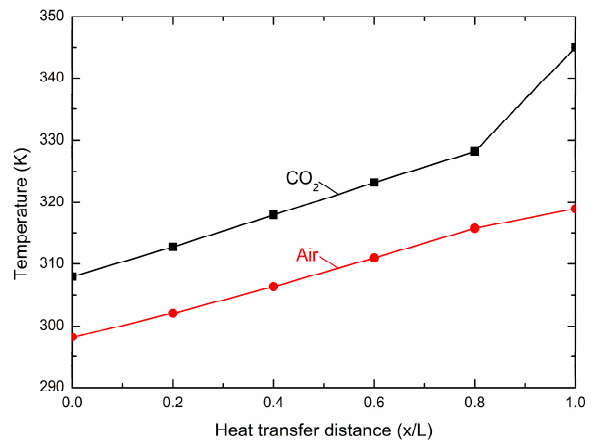
Figure A1. The air temperature through the overall length of the cooling tower. Energies 2019 , 12 , x FOR PEER REVIEW